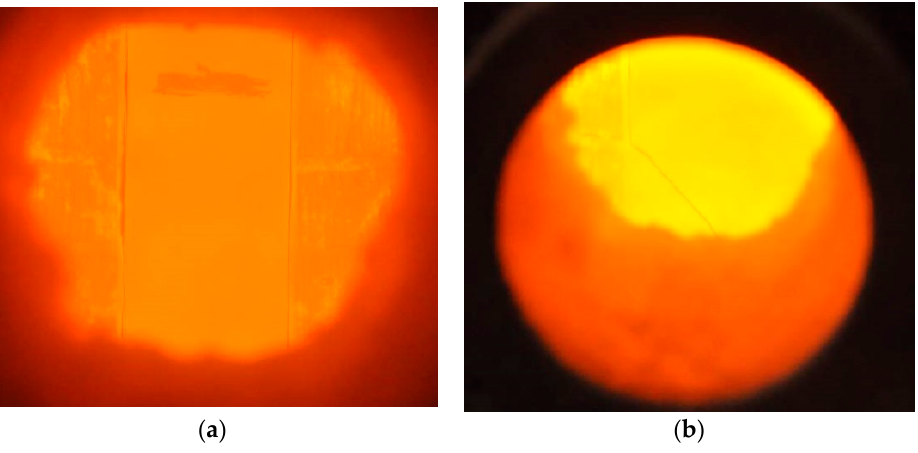
Figure 5. View of test specimen HSS-C2 through the observation window: ( a ) at about 10 min; ( b ) at about 25 min. Table 2. Test results of the columns.